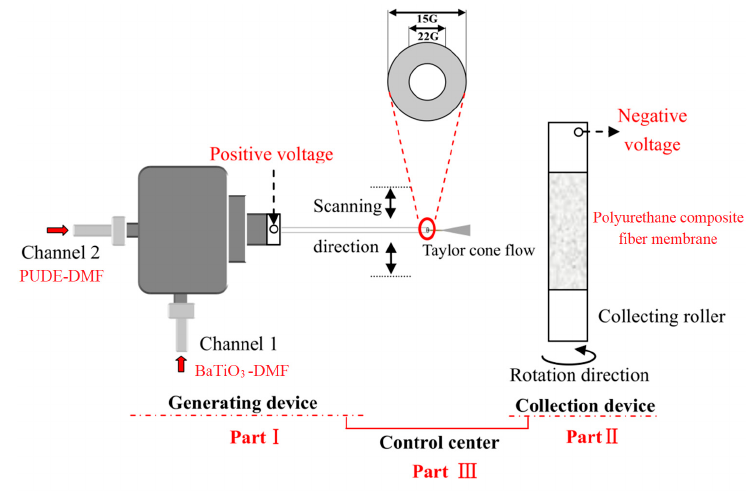
Figure 3. Schematic diagram of the coaxial spinning technique.